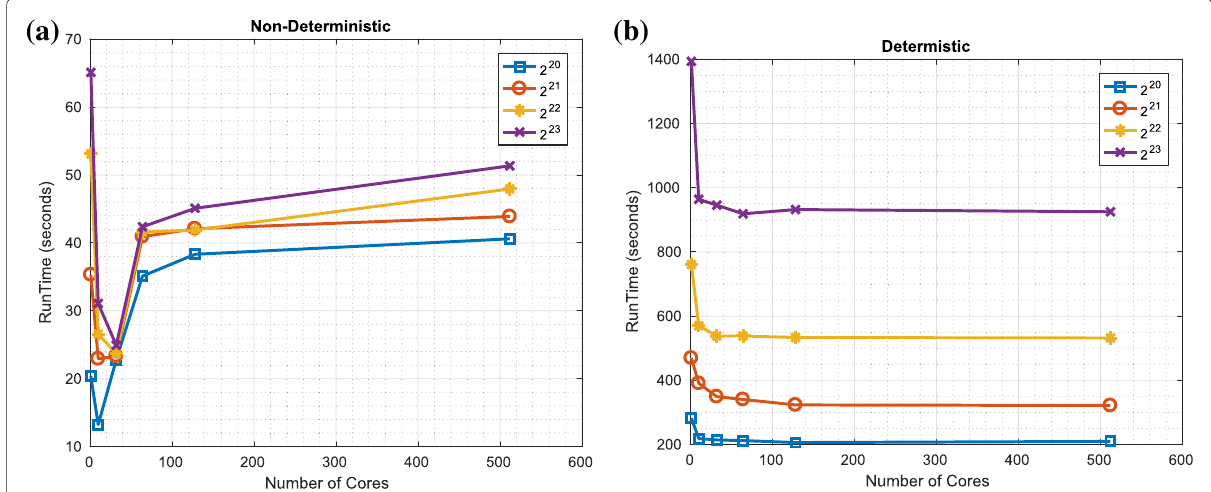
Fig. 6 Worst-case performance of redistribution: platform 2. a Naïve implementation. b Proposed approach